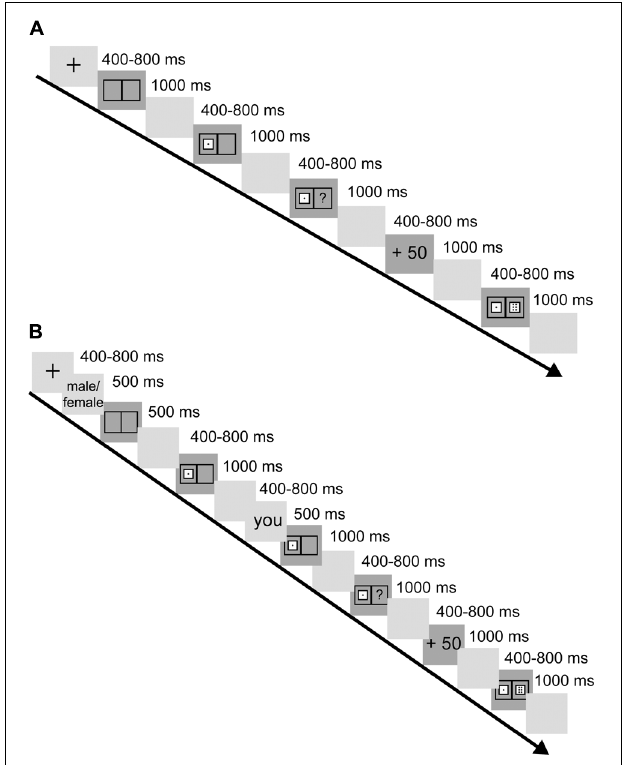
FIGURE 1 | (A) Schematic of a trial in the solo block. (B) Schematic of a trial within the partner